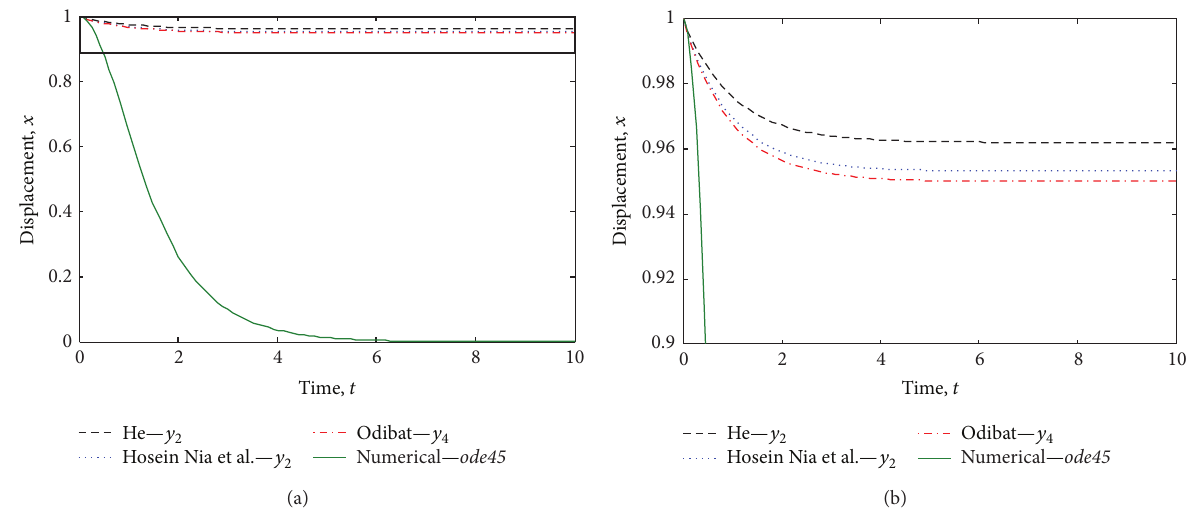
Figure 2: Numerical comparisons between the Runge-Kutta method ( ode45 ) and the numerical predictions provided by the approximate solutions of (8) derived by using the MHPM approach. Here Δ𝑡 = 0.1